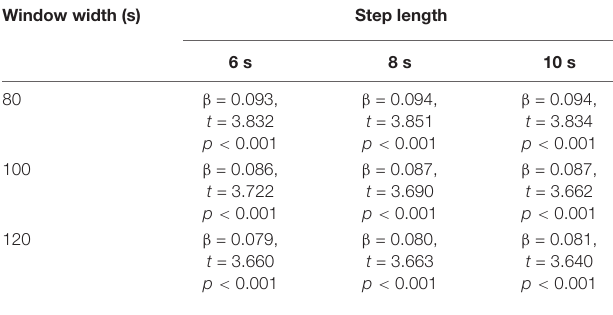
TABLE 5 | Main effect of age in the prediction of DMN dFC variability, when dFC was calculated with different window widths/step lengths. Window width